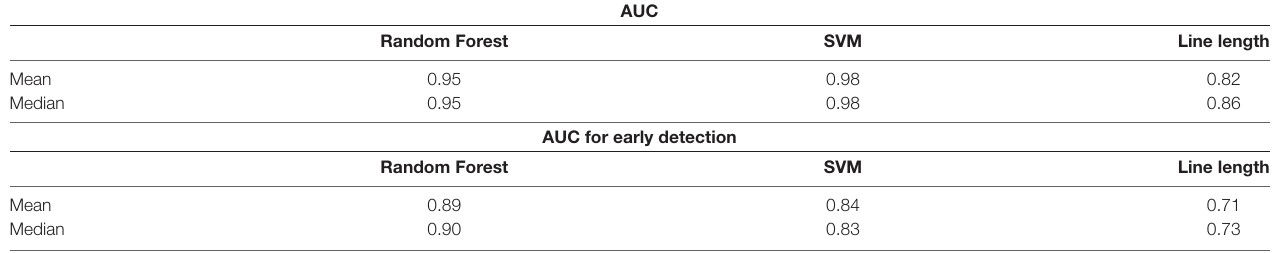
TABLE 2 | Comparison of the AUC over all the patients between the classifiers in multichannel